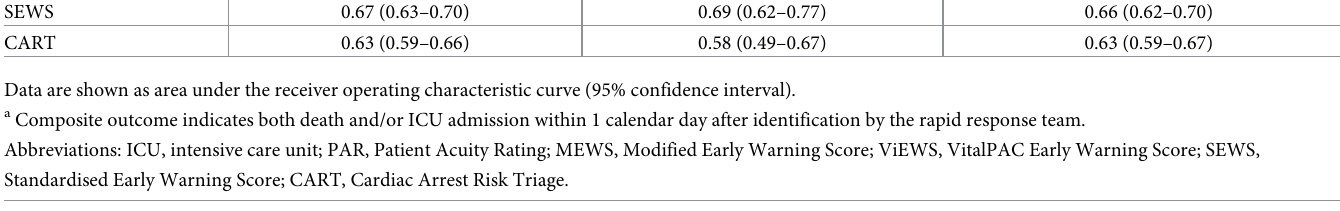
Table 2. Areas under the receiver operating characteristic curve of scoring systems for predicting short-term prognoses. Score Composite outcome a Mortality within 1 day PAR 0.87 (0.84–0.89) MEWS ViEWS 0.69 (0.66–0.73) SEWS 0.67